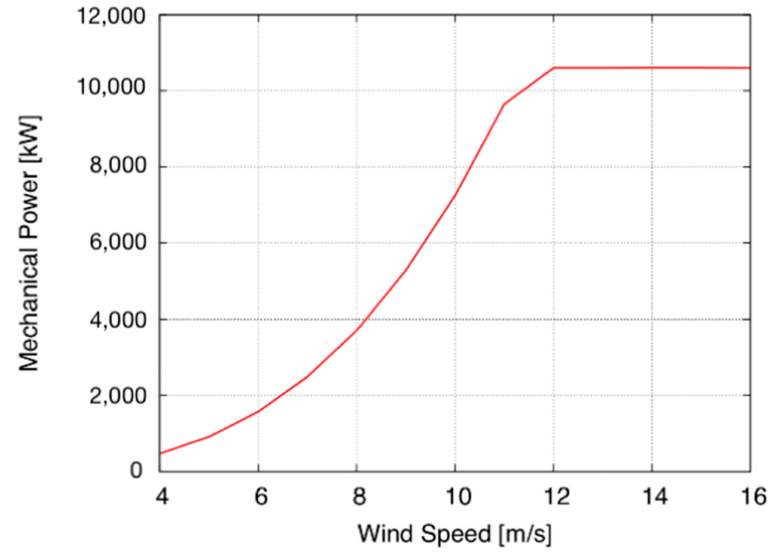
Figure 1. Power curve of the DTU 10MW wind turbine.